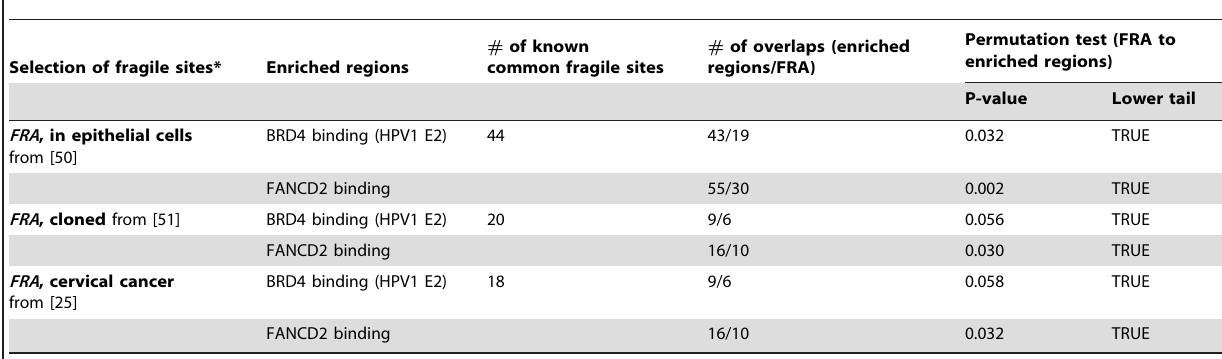
Table 1. Association of common fragile sites with PEB-BLOCs and FANCD2